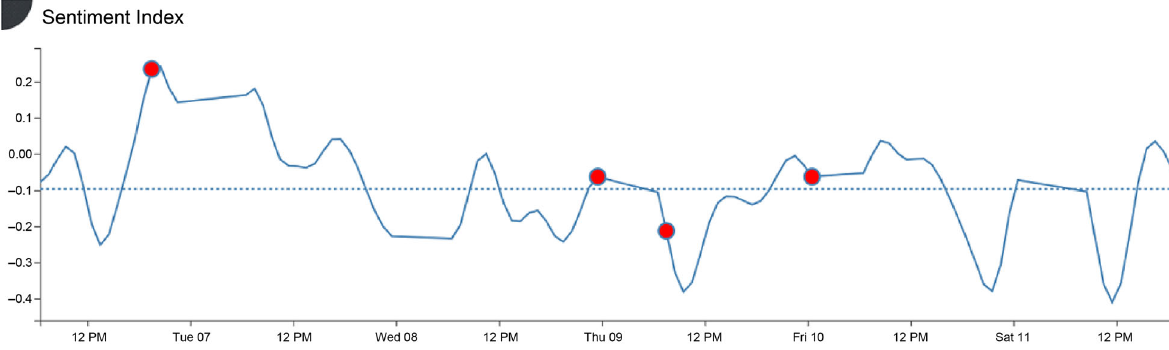
Fig. 7 Hacker attack case: phase2 sentiment